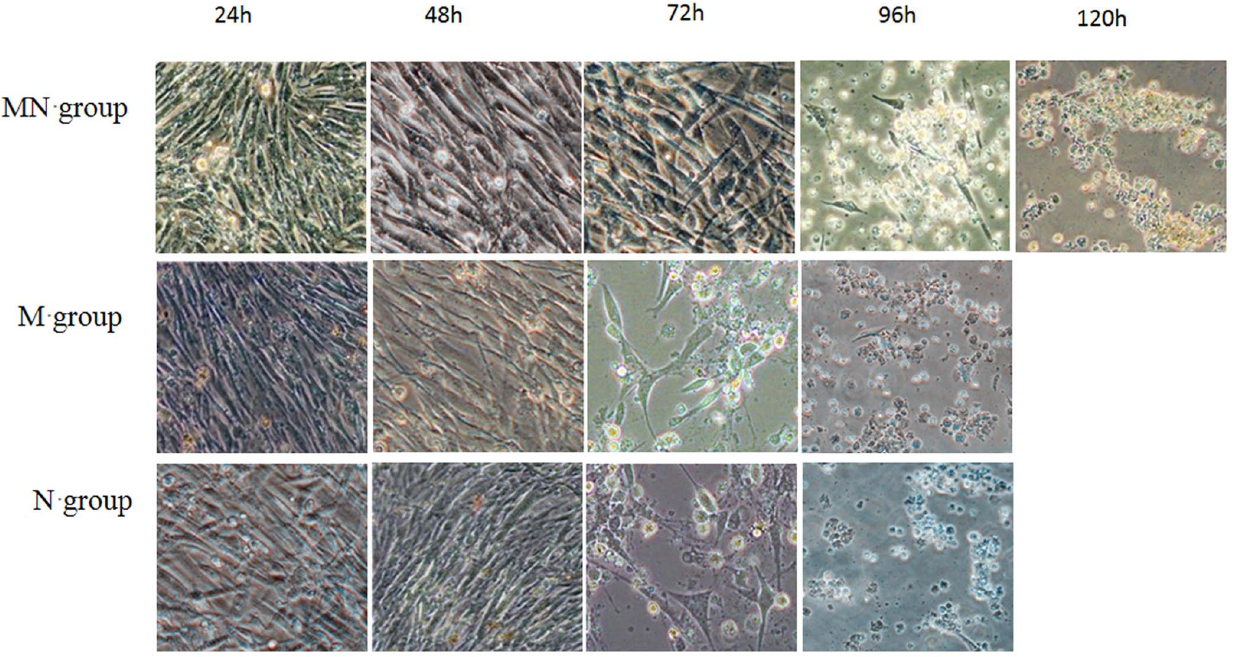
Figure 4. The cell morphology of CEF inoculated NDV for each antibody group at different time (200 6 ). CEF cells were seeded into 6- well plate, the antibody Mx-NA, Mx and NA was add into different well after the CEF cells grew into monolayer, then 100 TCID50 NDV was added into each well (in triplicates). The cell cultures were observed under microscope for cytopathic effect (CPE) at different time. MN group: Mx-NA antibody group; M group: Mx antibody group; N group: NA antibody group. doi:10.1371/journal.pone.0071688.g004 while, GAPDH was amplified. All above indicated Mx and NA were expressed in NIH 3T3 cells.